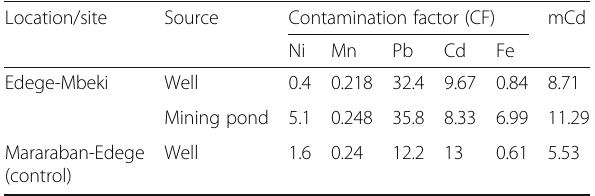
Table 5 Contamination factors (CF) and